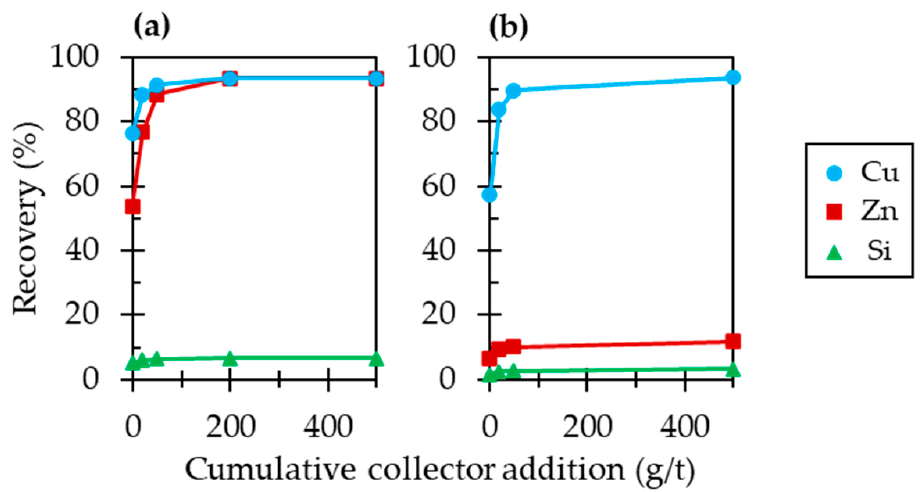
Figure 7. Flotation results of sphalerite and chalcopyrite with zinc sulfate ( a ) 0 kg/t and ( b ) 1 kg/t. Note that the data at 100 g/t of collector in Figure 7a and those at 100 and 200 g/t of collector in Figure 7b were absent due to the lack of froth amounts for the XRF.